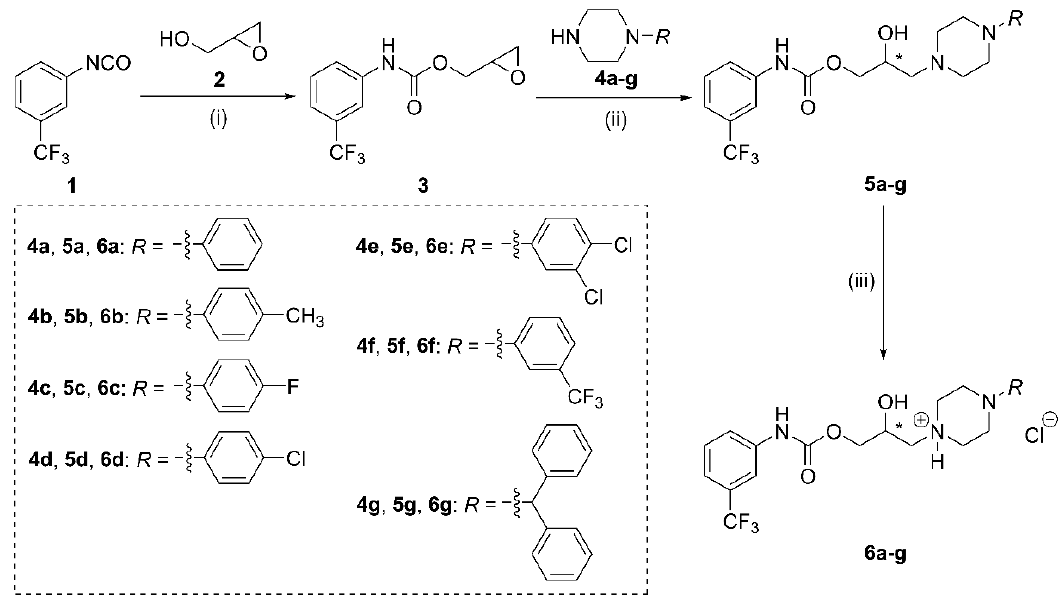
Figure 4. Synthesis of the intermediates (i.e., 3 and 5a – g ) and in vitro biologically screened com- pounds (i.e., 6a – g ). Reagents and conditions: ( i ) anhydrous toluene, continuous stirring at 70 °C for 25 h; ( ii ) anhydrous propan-2-ol, continuous stirring at reflux for 20 h; ( iii ) saturated solution of hydrogen chloride in diethyl ether. (* = chiral center)